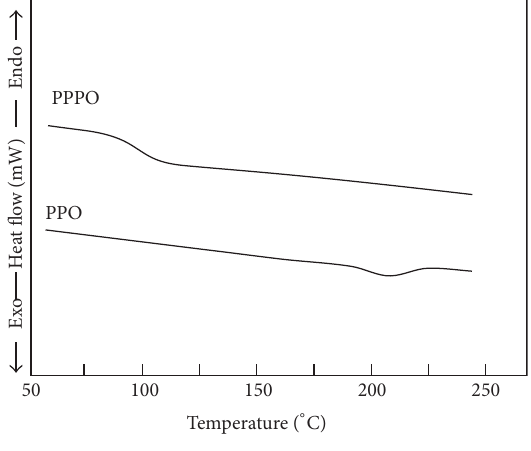
Temperature ( ∘ C) F 4: DSC thermograms of PPO and